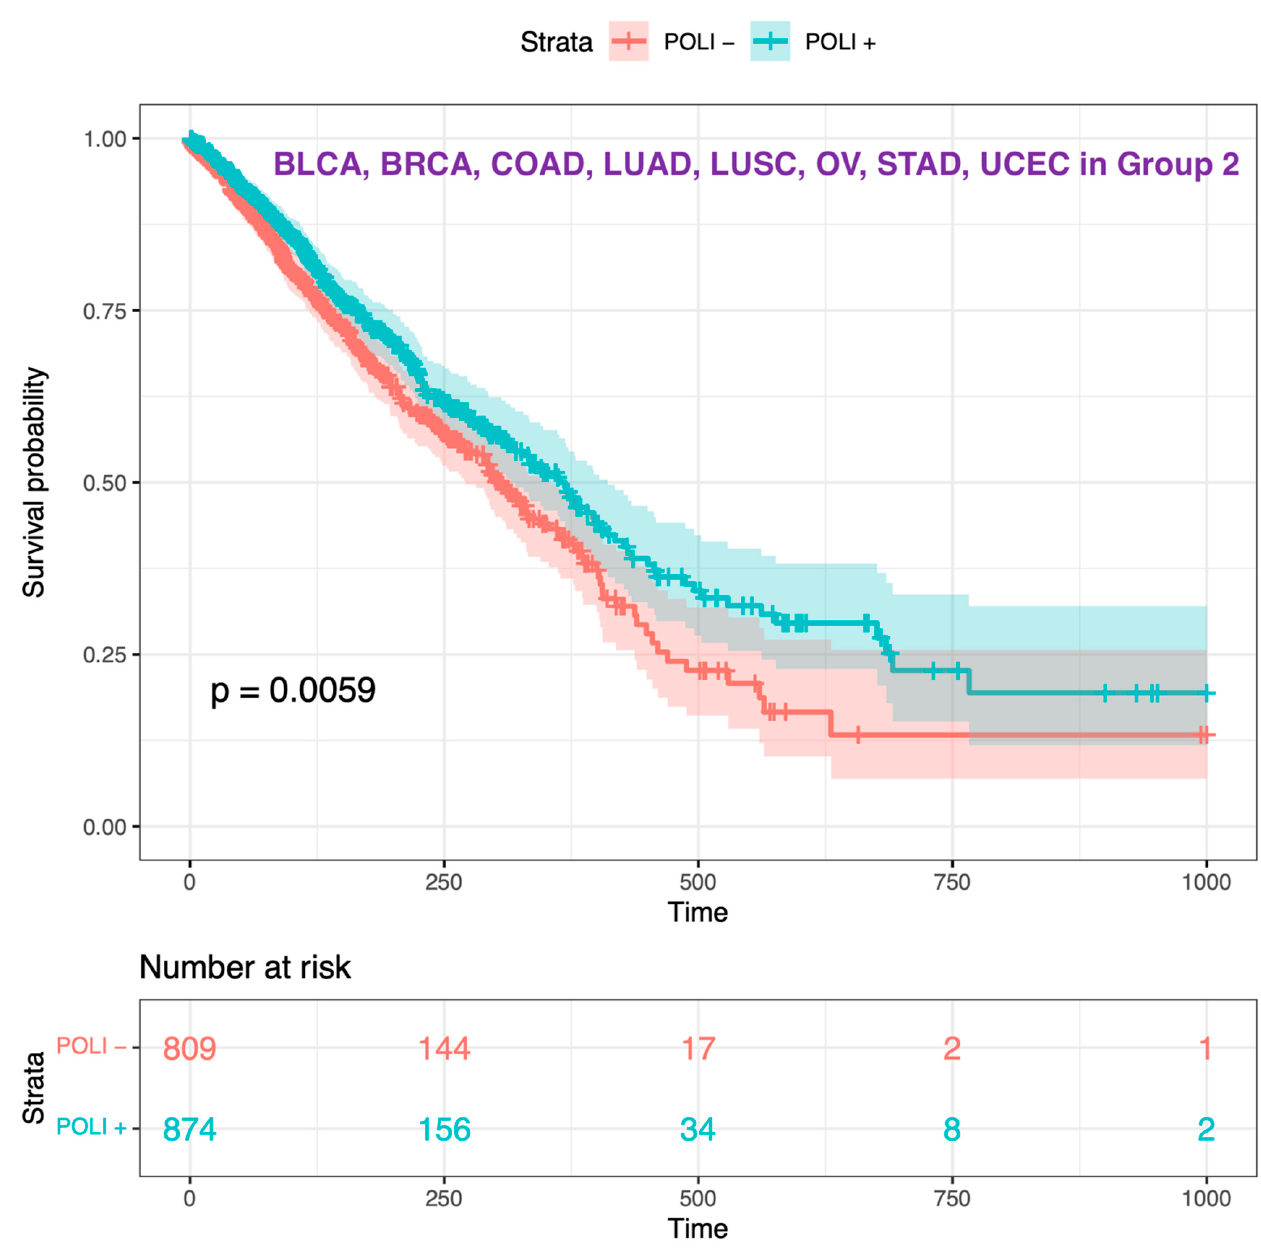
Figure 2. Reoccurrence of the prognostic value of POLI expression in regrouped cancer types: ( a ) K-M plot of POLI expression for patients in BRCA, HNSC, LIHC, SKCM, STAD, and UCEC from Group 1; ( b ) K–M plot of POLI expression for patients in BLCA, BRCA, COADREAD, LUAD, LUSC, OV, STAD, and UCEC from Group 2.